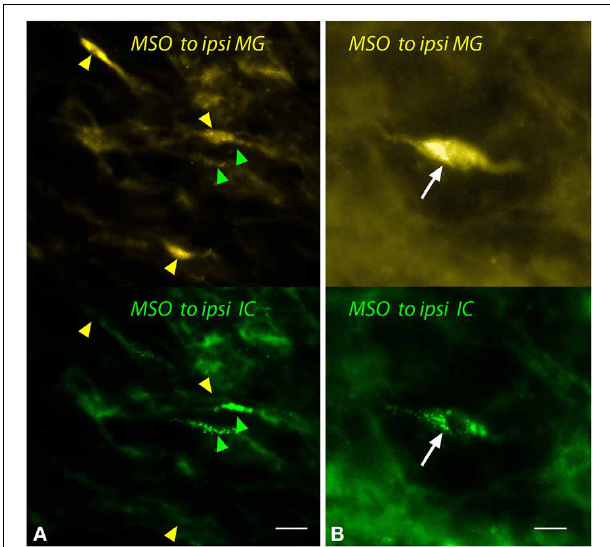
FIGURE 5 | Photomicrographs showing labeled cells in the medial superior olivary nucleus (MSO) after injections into the medial geniculate nucleus (MG) and the inferior colliculus (IC). Panels show FluoroGold (upper image) and green beads (lower image). (A) Single-labeled cells that contained only FluoroGold (yellow arrowheads) or only green beads (green arrowheads). (B) A double-labeled cell (white arrow) contained both tracers. Transverse sections; dorsal is up; lateral is to the left. Scale bar = 20 µ m (A) or 10 µ m (B) . ipsi, ipsilateral.